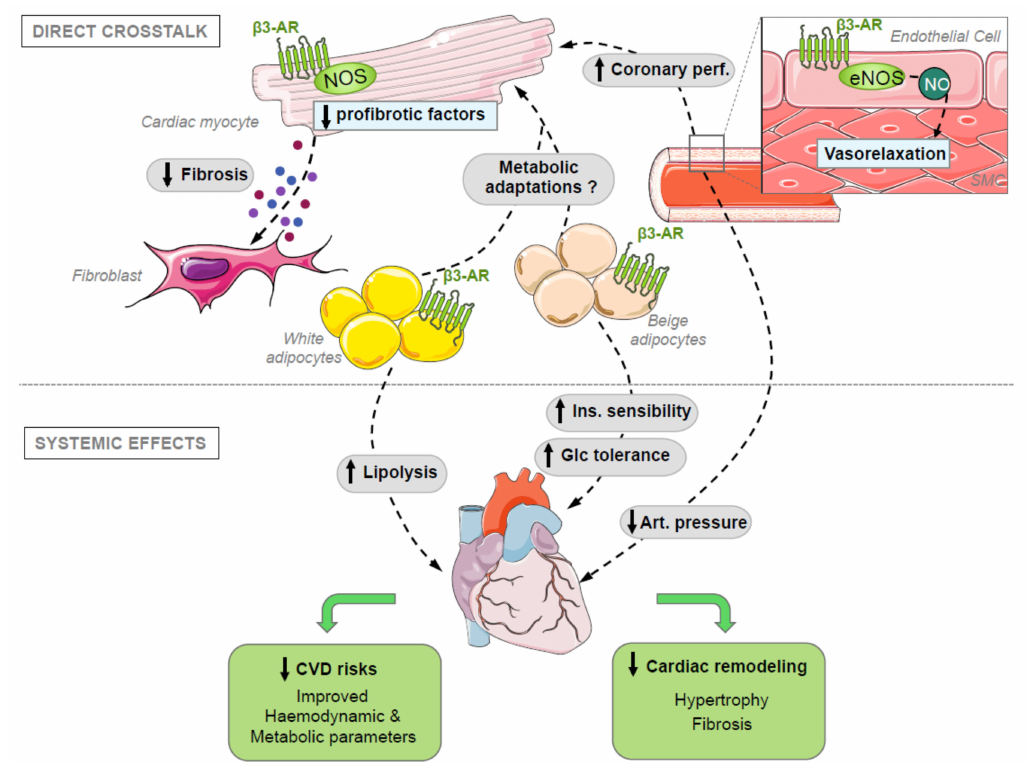
Figure 2. B3AR-mediated cardiovascular protection through paracrine and systemic signaling. β